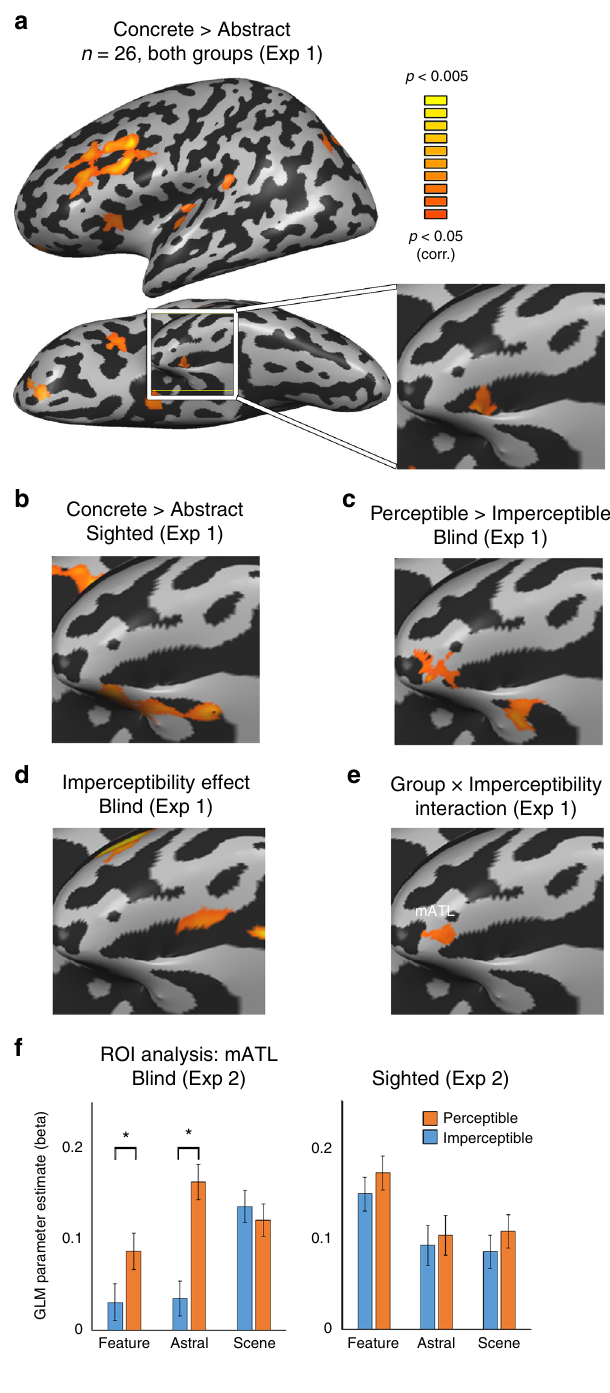
by the blind and ratings of visual perceptibility by the sighted. While a small area in the medial ATL displayed RSA correlation for both analyses, this cluster was not suf fi ciently signi fi cant to survive the multiple comparisons